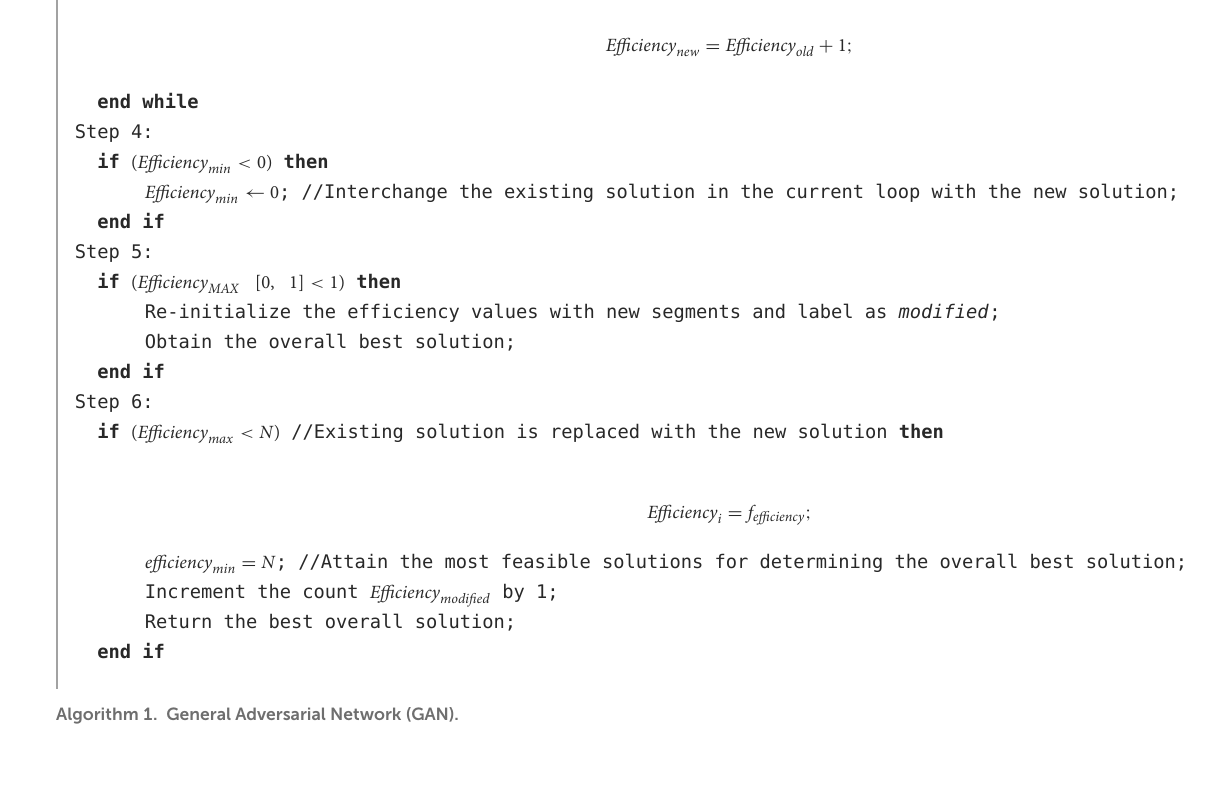
Algorithm 1. General Adversarial Network